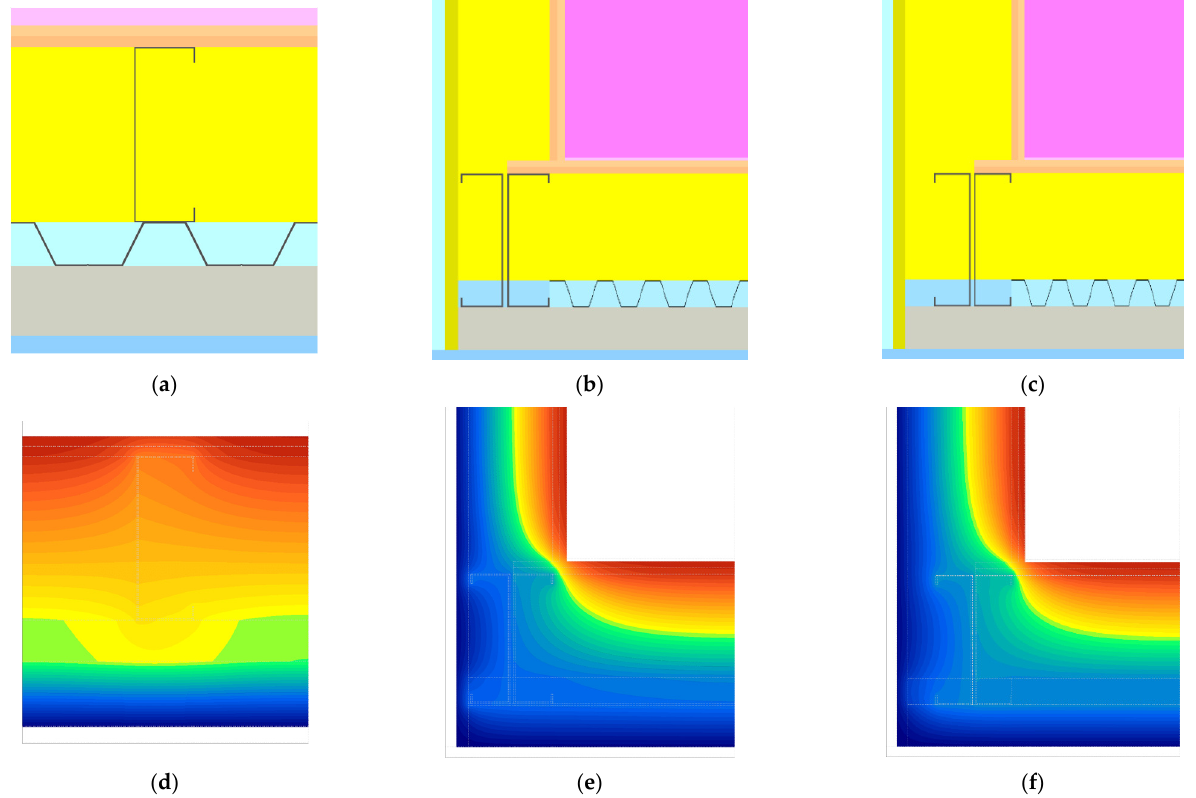
Figure A6. The floor in contact with the exterior-Geometrical models: ( a ) current field, ( b ) exterior wall (E, W)—floor in contact with the exterior, ( c ) exterior wall (N)—floor in contact with the exterior; Isothermal surfaces ( d ) current field, ( e ) exterior-wall-floor in contact with the exterior, ( f ) exterior wall (N)—floor in contact with the exterior.